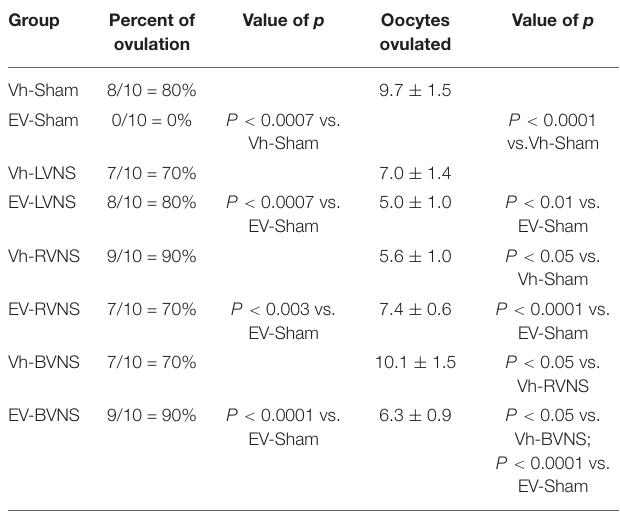
TABLE 2 | Percentage of ovulating animals and mean ± SEM number of total oocytes ovulated by rats treated with vehicle (Vh) or estradiol valerate (EV) at day 10 of life, with sham surgery (sham) or unilateral (LVNS or RVNS) or bilateral (BVNS) vagotomy at day 76 of life.